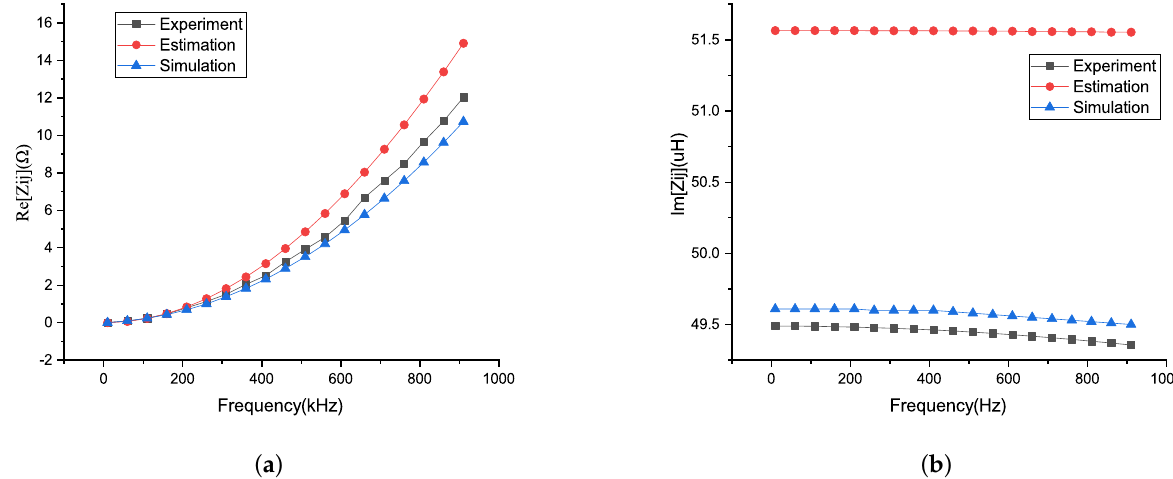
Figure 7. ( a ) The real part of mutual impedance of two coils as a function of the excitation frequency. ( b ) The imaginary part of mutual impedance of two coils as a function of the excitation